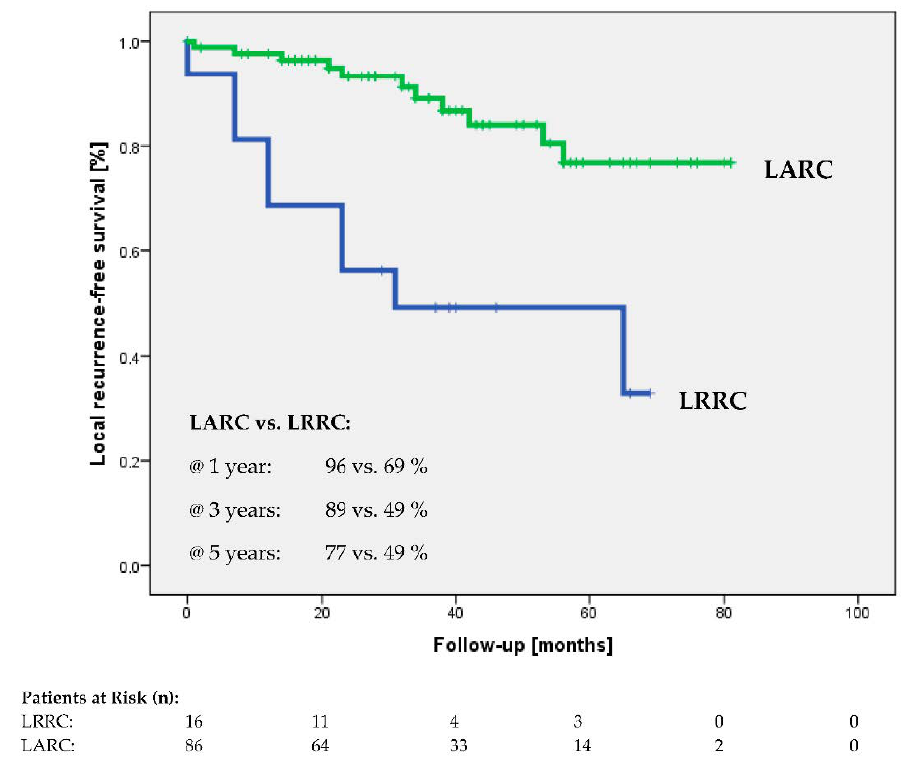
Figure 2. Local recurrence-free survival of locally advanced (LARC) and locally recurrent (LRRC) rectal cancer.